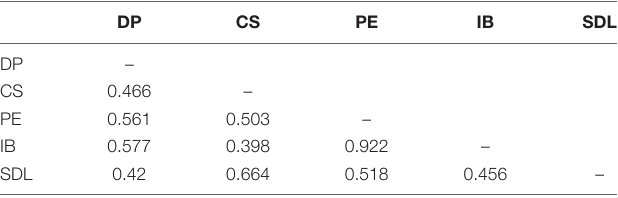
TABLE 3 | HTMT Ratio of correlations among the Flipped English learning readiness questionnaire